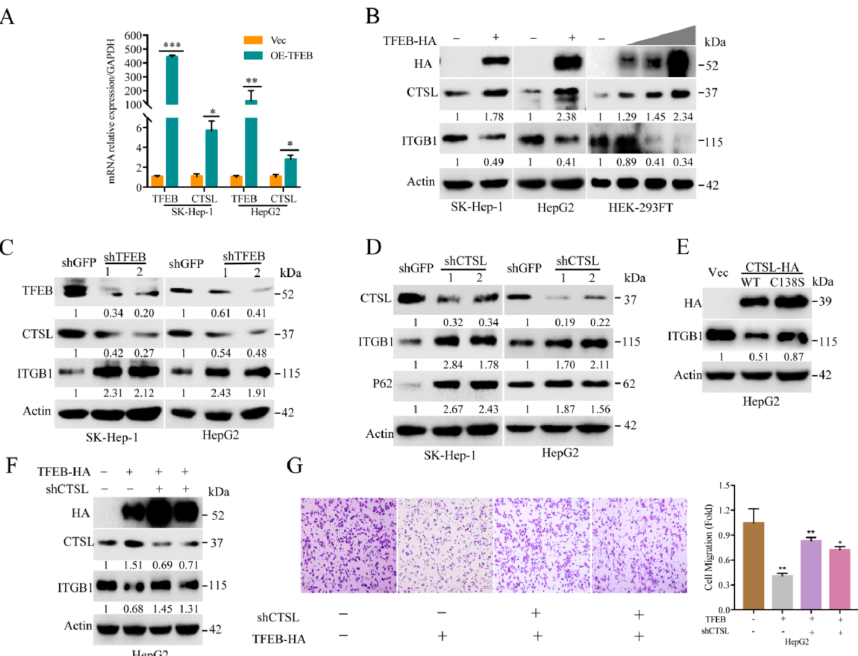
Figure 5. TFEB-mediated upregulation of lysosomal CTSL promotes ITGB1 degradation. ( A ) The mRNA level of CTSL and TFEB of HepG2 or SK-Hep-1 cells expressing TFEB were determined by RT-qPCR analysis. The experiment was repeated three times for statistics; ( B ) HepG2 or SK-Hep-1 cells stably expressing TFEB or HEK-293FT transfected with vector control or 0.5, 1, or 2 µ g of TFEB-HA plasmid were subjected to Western blotting analysis; ( C ) HepG2 or SK-Hep-1 cells were infected by lentivirus to knockdown TFEB, followed by Western blotting analysis; ( D ) HepG2 or SK-Hep-1 cells with knockdown of CTSL were subjected to Western blotting analysis; ( E ) HepG2 cells expressing either CTSL-HA or CTSL-HA (C138S) were subjected to Western blotting analysis; ( F – G ) HepG2-TFEB-HA or SK-Hep-1-TFEB-HA cells were infected by lentivirus to knockdown CTSL, followed by Western blotting ( F ) or Transwell assay ( G ). Scale bar = 100 µ m. The experiment was repeated three times and five visual fields were counted for each condition. For ( D ), scale bar = 100 µ m. * p < 0.05, ** p < 0.01, and *** p < 0.001. N.S. = no